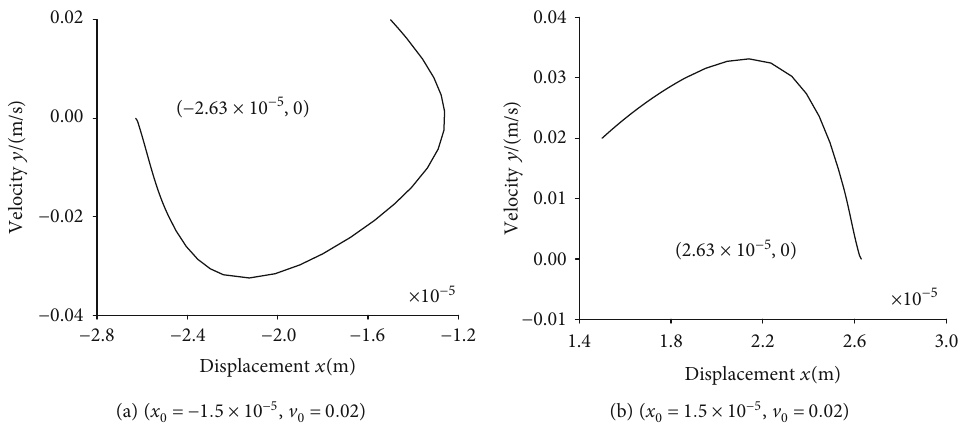
Figure 17: Phase trajectories under i